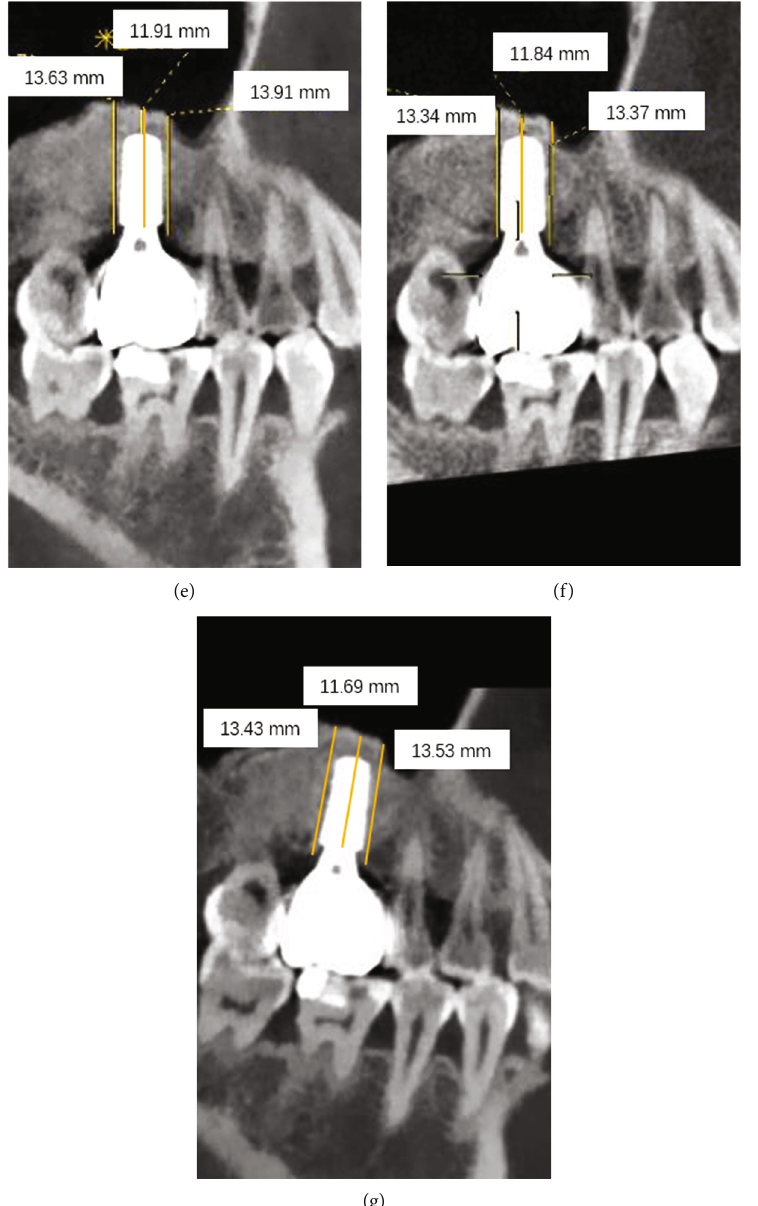
Figure 3: CBCT and pantomograph follow-up for tooth #16. (a) Before MSFE. (b) Immediately after MSFE (pantomograph). (c) 3 months after MSFE. (d) 10 months after MSFE. (e) 15 months after MSFE. (f) 26 months after MSFE. (g) 35 months after